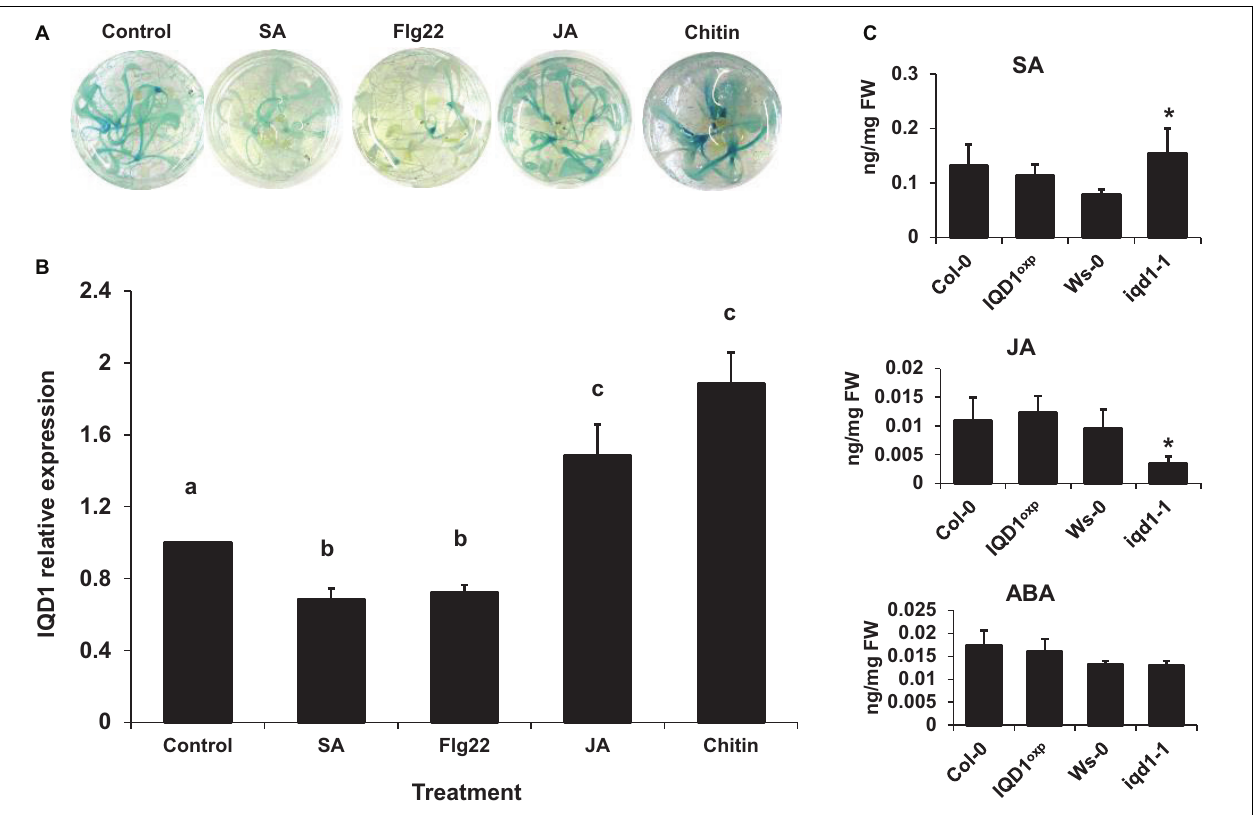
FIGURE 3 | Elicitors affect IQD1 expression. Transgenic seedlings of gene trap line IQD1pro:GUS were treated with 100 µ M salicylic acid, 100 nM Flg22, 100 µ M jasmonic acid, 500 µ g/ml chitin or an equal volume of water as control for 18 h prior to histochemical GUS staining (A) or RNA extraction followed by qRT-PCR (B) . Results shown are from a biological replicate representative of six independent experiments for GUS staining and three for qRT-PCR. (C) SA, JA, and ABA accumulation in IQD1 mutants. Plant hormones were extracted from 3 week-old Arabidopsis seedlings grown on half-strength MS agar plates. Quantitative analysis of plant hormones was accomplished using LC-MS/MS with isotopically labeled analogs serving as internal standards. Each column represents an average of three independent biological replicates, with standard error bars indicated. Different letters above the columns indicate statistically significant differences at P < 0.05, as determined using Tukey’s honest significant difference test. Asterisks above the columns indicate statistically significant differences relative to WT plants at P < 0.05, as determined using Student’s t